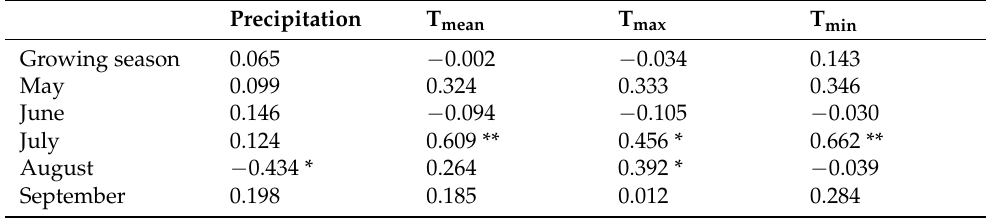
Table 1. Correlation coefficients between growing season (monthly) NDVI of marsh vegetation and growing season (monthly) T mean , T min , T max and precipitation during the growing season in Sanjiang Plain from2000 to 2020.